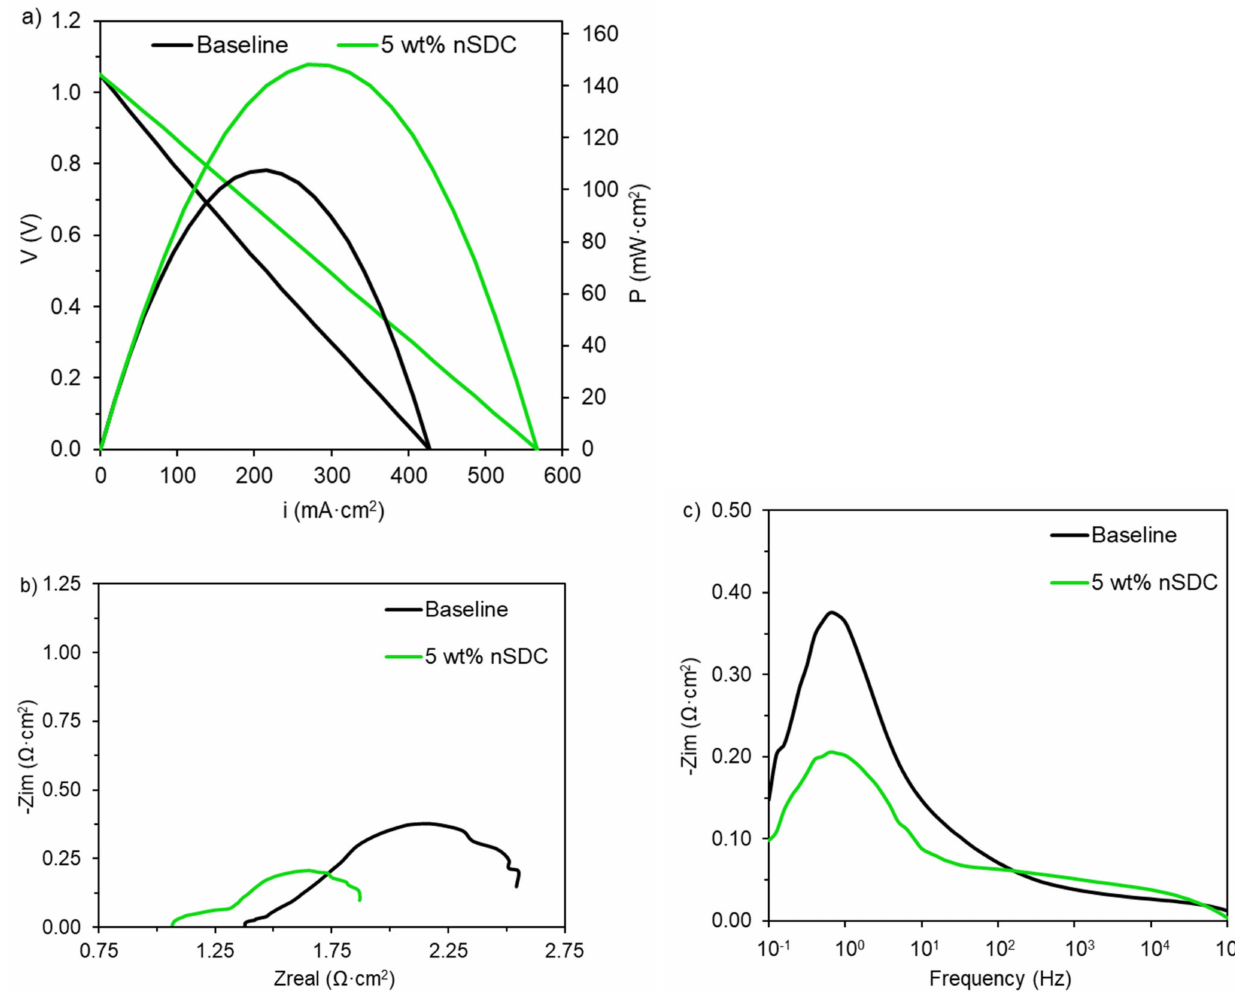
Figure 7. ( a ) Fuel cell i-V-P performance, ( b ) Nyquist plots, and ( c ) Bode plots for an LSCF-SDC baseline cathode versus an LSCF-SDC-nSDC cathode comprising 5 wt% nSDC at 700 ◦